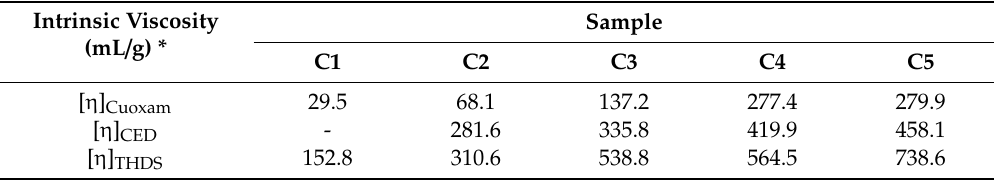
Table 3. Comparison of the intrinsic viscosity the cellulose solutions. Intrinsic Viscosity (mL/g) *